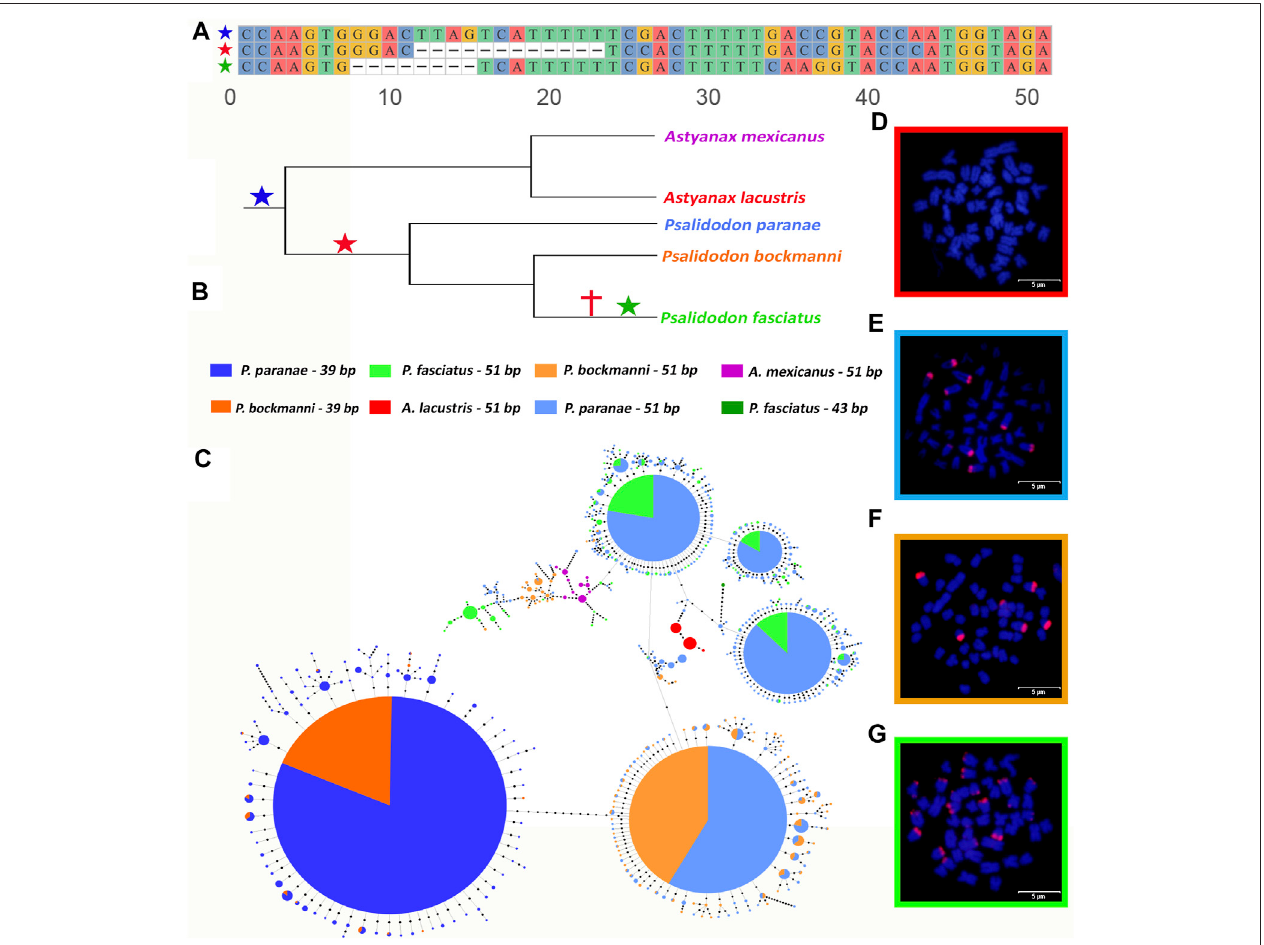
FIGURE 2 | Structure and conservation of As51 monomers between Psalidodon and Astyanax. Alignment of As51 variants, with 51 bp, 39 bp, and 43 bp, respectively (A) . The emergence and disappearance of each variant is demonstrated in the phylogeny of species (blue = 51 bp, red = 39 bp, green = 43 bp) (B) . Stars representsthesurgingofavariationofAs51andcrossesrepresentstheeliminationofavariationofAs51.LinearMSTdemonstratingthehaplotypesofvariantsofAs51in Astyanax and Psalidodon species (C) .Highlightofthe dominance ofahaplotype ofAs51-39 bp shared between Psalidodon bockmanni and Psalidodon paranae , and the mostrelevantoffour haplotypes ofAs51-51 bp shared between P.bockmanni and P. paranae (1)and P.paranae and Psalidodon fasciatus (3) (C) .As51do not demonstrates FISH signals in Astyanax lacustris (D) , but this marker forms greats cluster on chromosomes of P. bockmanni , P. paranae , and P. fasciatus (E – G) . Fish images were captured in a magni fi cation of ×1000.